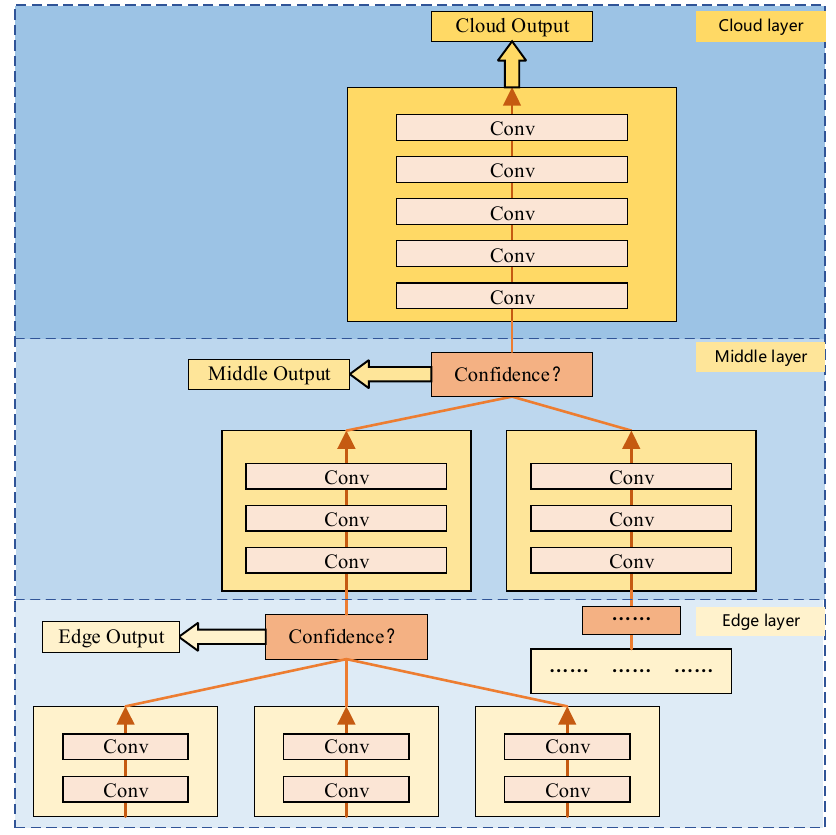
Figure 5. Distributed deployment of CNN in AIBot.